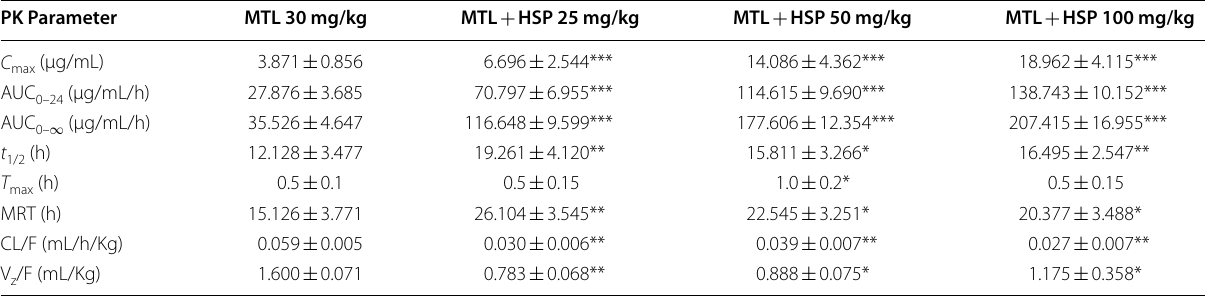
Table 1 Pharmacokinetic parameters of metoprolol succinate in the presence or absence of hesperetin (25, 50, and 100 mg/kg) on the 1st day (n 6) =